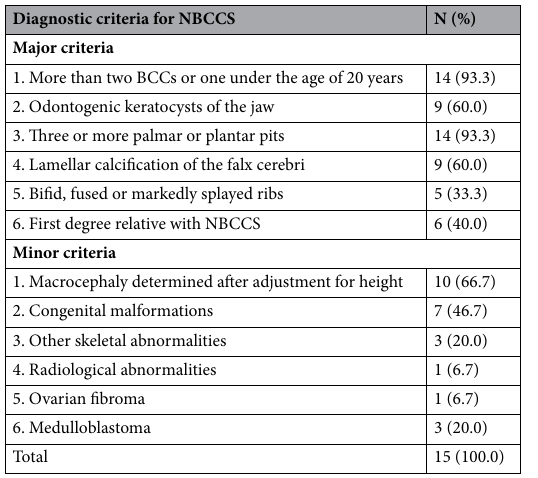
Table 1. Diagnostic criteria for NBCCS and clinical phenotype of 15 Korean patients. NBCCS nevoid basal cell carcinoma syndrome, BCC basal cell